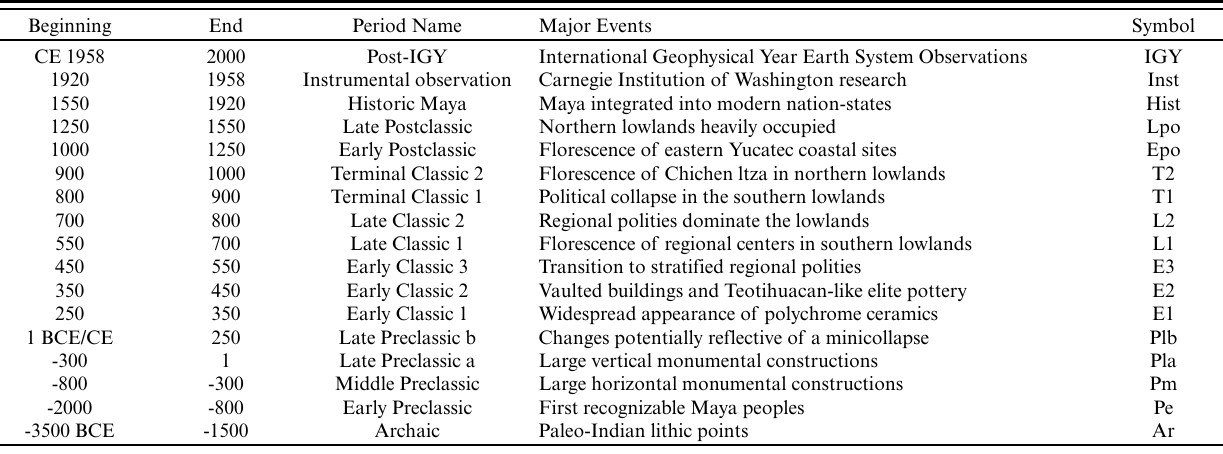
Table 1 . Integrated History and Future of People on Earth (IHOPE)–Maya area-wide BCE-CE chronology (adapted from Chase et al.